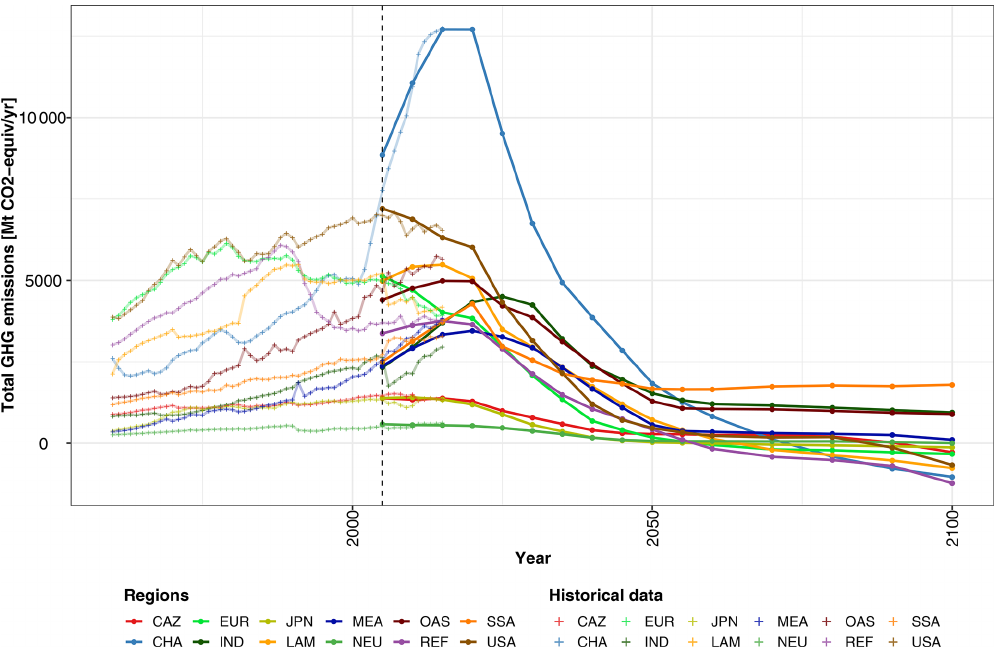
Figure 6. Regional total GHG emissions by type for the 1.5 ◦ C scenario (pkBudg900) of SSP2 with historical data from PRIMAPhist (Gütschow et al., 2016).